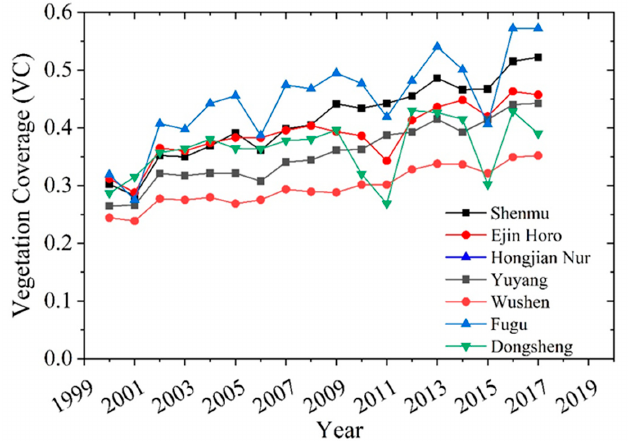
Figure 4. Average VC change in six counties (Shenmu, Ejin Horo Banner, Yuyang District, Wushen, Dongsheng District, and Fugu) during 2000-2017.